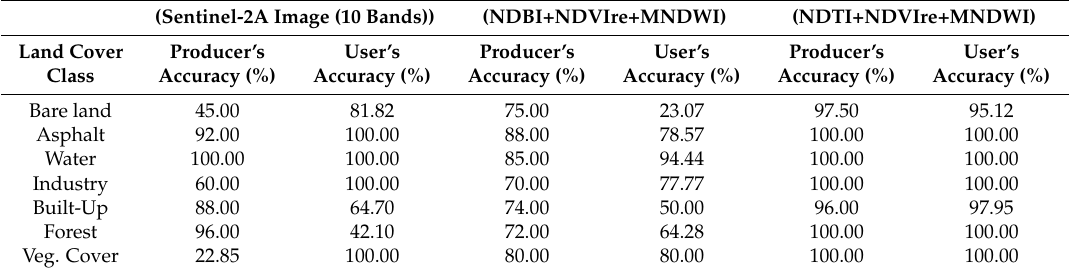
Table A1. Classification accuracies of the different approaches for Figure 8.